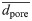
Swelling and hydration of the pore.(A) Pore diameter, d
pore, along the pore axis, z. Average values from all simulations (solid red line) with and (broken blue line) without regulatory ions; (dotted black line) conformations with N
wat>20 in all eight SSH simulations; and single conformation with the largest values of mean pore diameter in the MM, dpore¯, from simulations (grey x symbols) with and (magenta circles) without regulatory ions. Vertical lines indicate average positions of terminal heavy atoms of pore-lining sidechains, connecting above residue labels to lines that extend to average Cα atom positions. Horizontal lines indicate the diameters of hexahydrated Mg2+ and water. The value z = 0 corresponds to the center of mass of MM backbone atoms. (B) dpore¯ as a function of N
wat for simulations (red triangles) with and (black circles) without regulatory ions. Shaded regions enclose one standard deviation of sampled values and error bars represent the uncertainty as the standard deviation of the mean after dividing the trajectories into two sets. Empty symbols denote an inability to assess the uncertainty because the corresponding value of N
wat was only sampled in one simulation block. Data for simulations with regulatory ions are offset by +0.5 N
wat units for clarity.